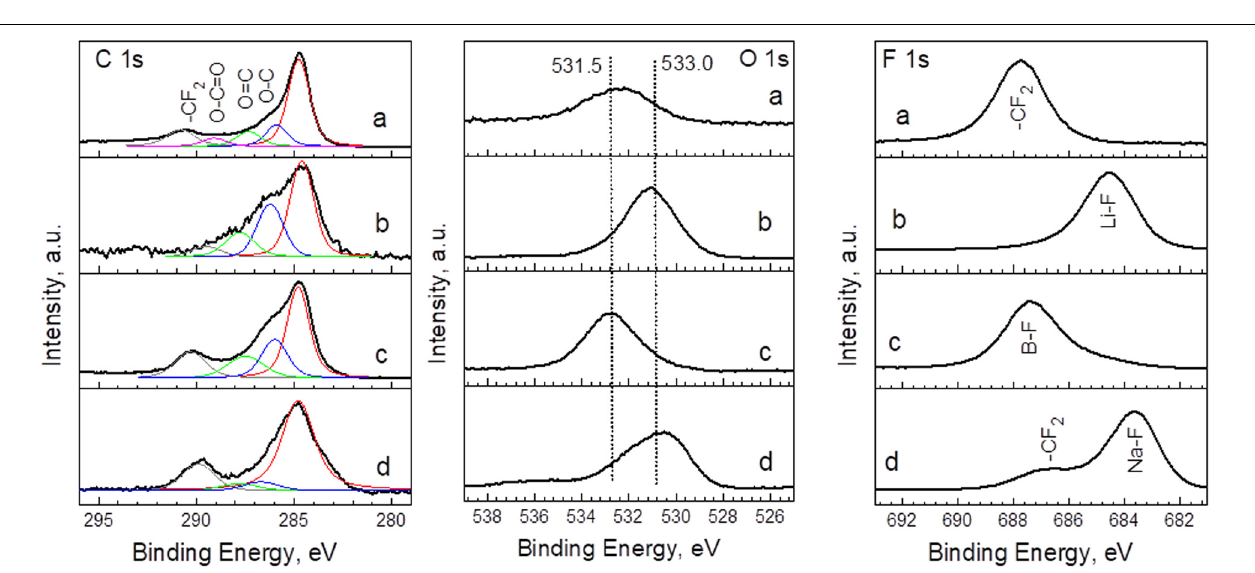
FIGURE 4 | Scanning electron microscopy images of the pristine AC electrode (A) , AC electrode after CV test in the LiBF 4 electrolyte (B) , LiPF 6 electrolyte (C) , and NaPF 6 electrolyte (D) .